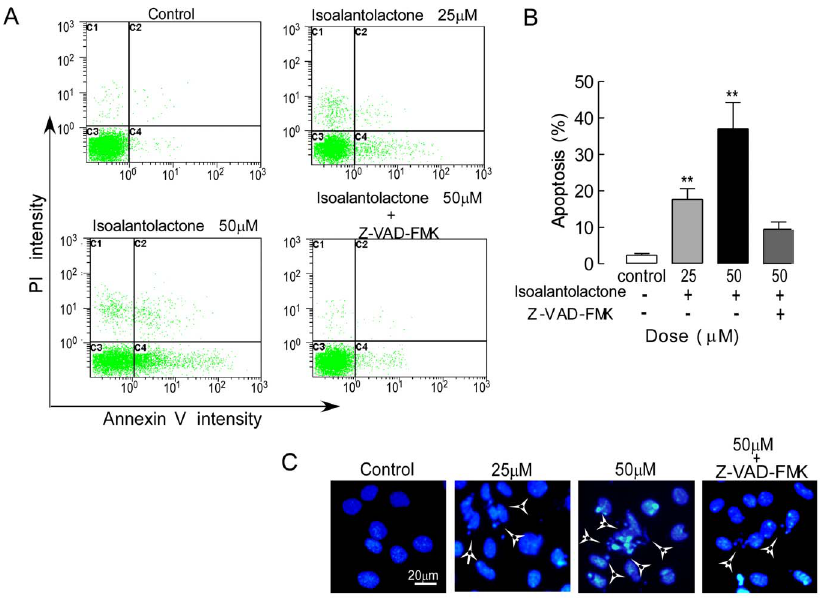
Figure 2. Isoalantolactone-induced apoptosis in UM-SCC-10A cells. (A) Apoptosis was evaluated using an annexin V-FITC apoptosis detection kit and flow cytometry. The X- and Y-axes represent annexin V-FITC staining and PI, respectively. The representative pictures are from UM- SCC-10A cells incubated with different concentrations of isoalantolactone (25 and 50 m M) or caspase inhibitor (Z-VAD-FMK 50 m M). (B) Isoalantolactone induced apoptosis in the UM-SCC-10A cells in a dose-dependent manner. Z-VAD-FMK markedly reduced apoptosis in UM-SCC-10A cells treated with high-dose isoalantolactone. The data are expressed as the means 6 SEM of three independent experiments with the similar results. * P , 0.05 and ** P , 0.01 compared to the control. (C) The morphological nuclear changes in UM-SCC-10A cells treated with isoalantolactone at different concentrations. The cells were stained with Hoechst33258 for 30 min in the dark to examine the cleaved nuclei, which is a sign of apoptosis.